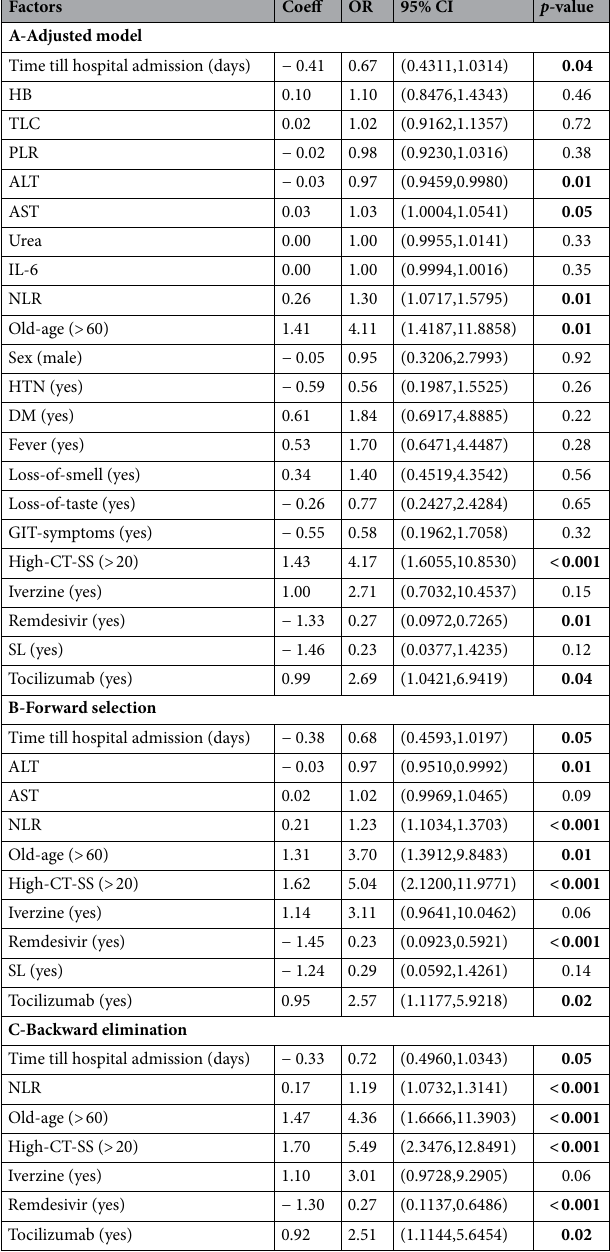
Table 2. Predictors of mortality using multivariate logistic regression model with different technique. Goodness of fit test: Hosmer–Lemeshow, P > 0.05 for all models, coeff: coefficient, OR: Odd ratio, CI: confidence interval, P < 0.05 considered significant, the sign before coefficient number denote the direction of relationship. Significant values are in